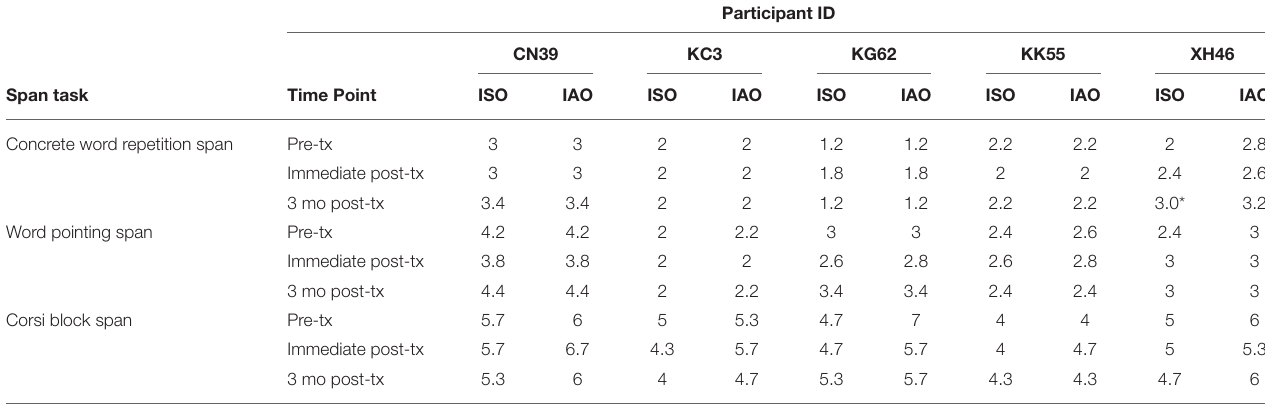
TABLE 3 | Spans in serial order (ISO) and in any order (IAO) at pre-treatment, immediate post-treatment, and 3 months